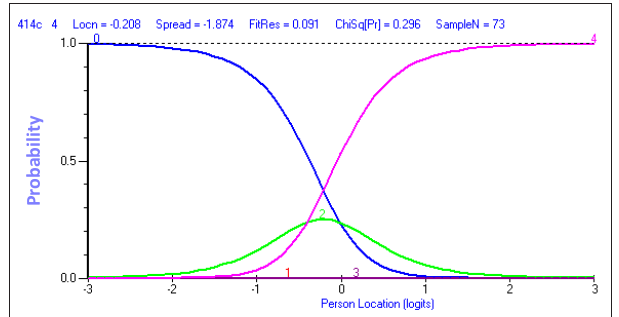
FIGURE 9: Category probability curves for Item 4.1.4.c.